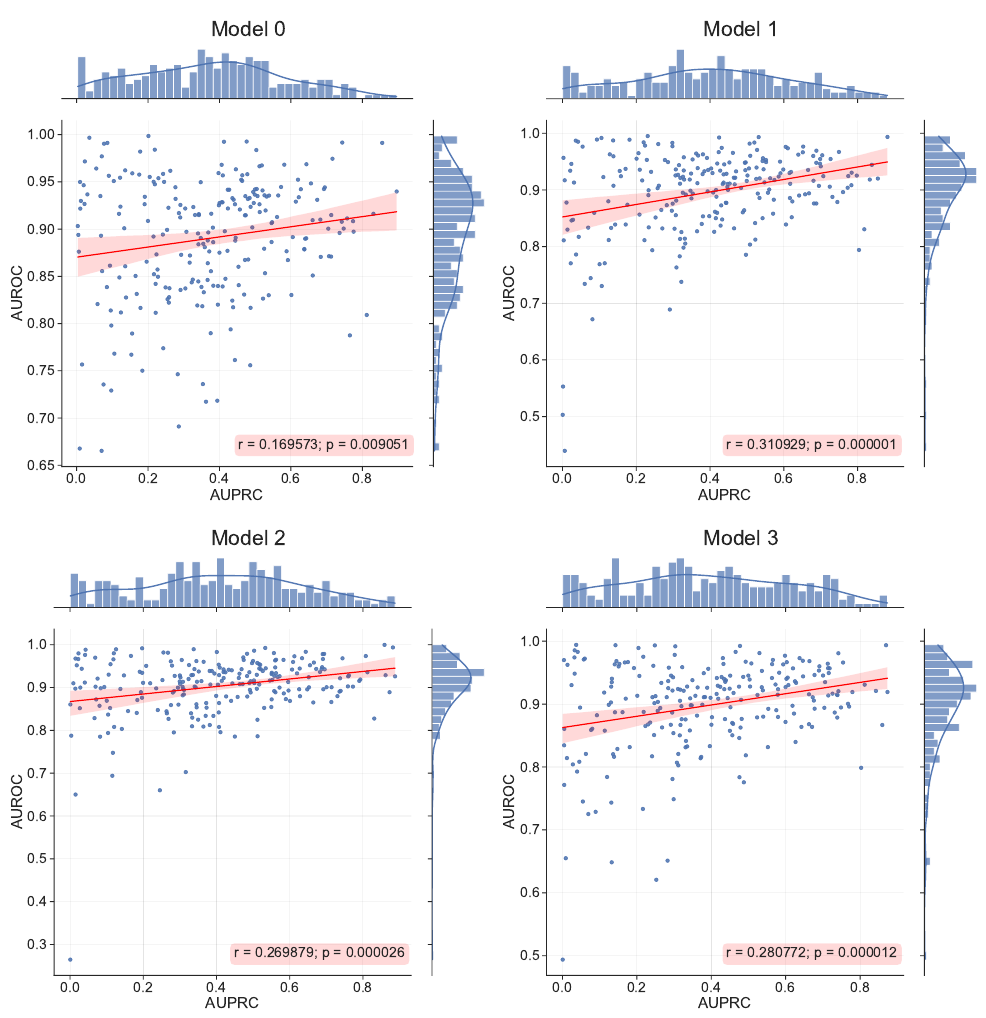
Figure 7. Correlation analysis of subject-wise AUPRC and AUROC